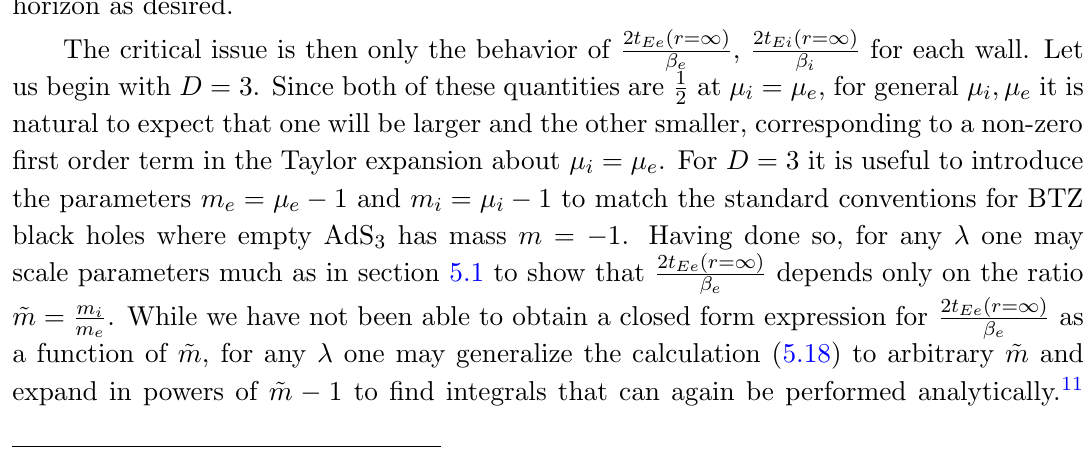
with (cid:21) = (cid:0) 1 (cid:0) " , " > 0, (cid:20) = 2, (cid:12) e < 1, the solutions are free (cid:12) e